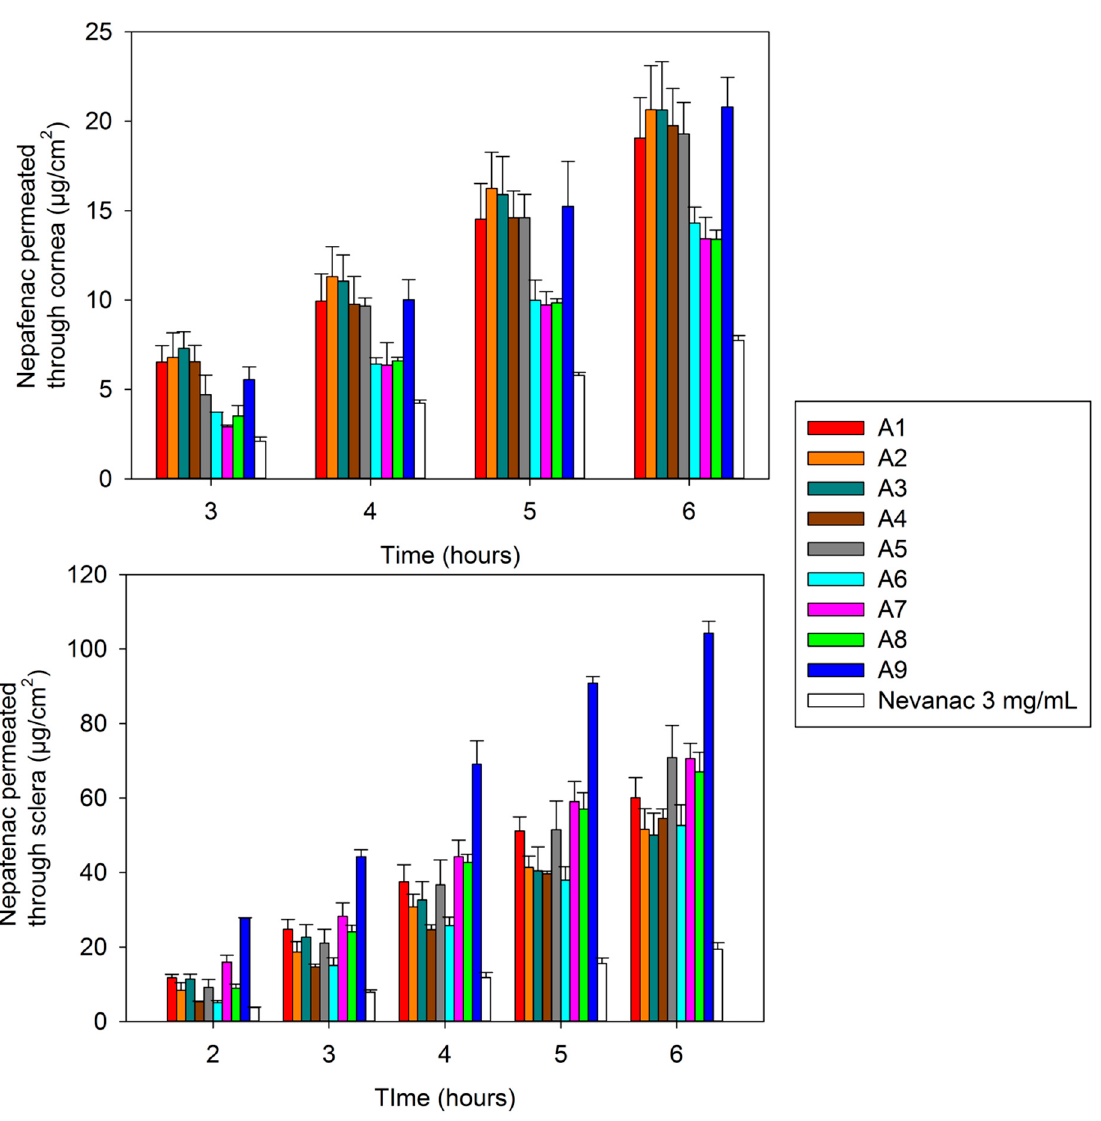
Figure 7. Amount of nepafenac permeated through bovine cornea ( top ) and sclera ( bottom ) measured in the receptor chamber as a function of time.